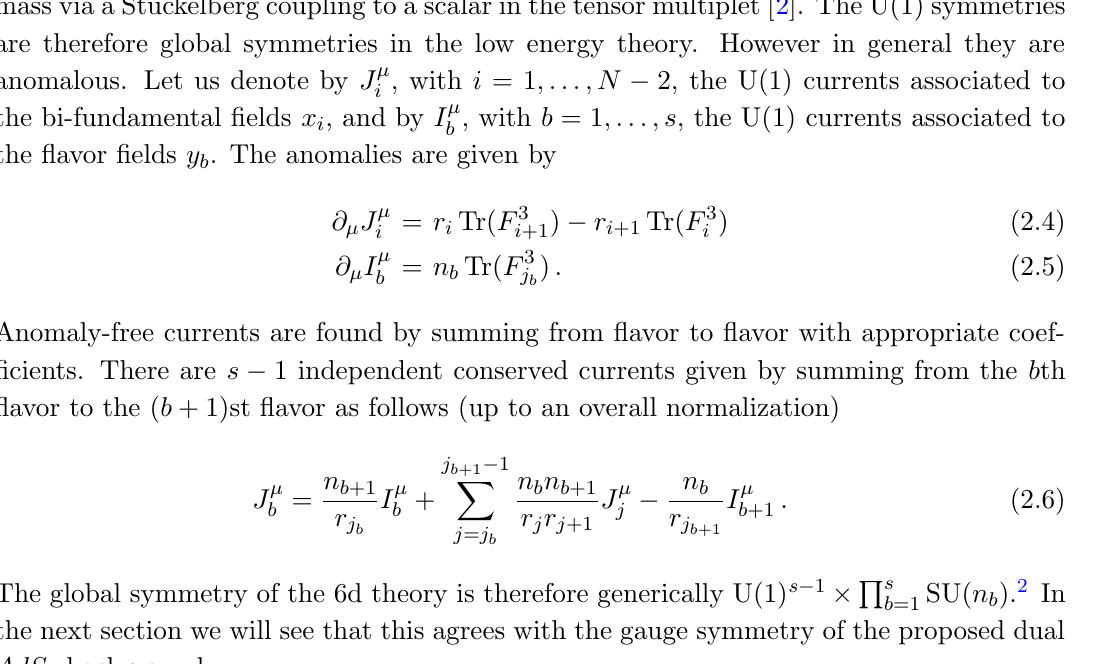
Figure 3 . The general 6d linear quiver theory with s sets of (cid:13)avors. We denote by x complex scalar components of the bi-fundamental hypermultiplets, and by y a ; ~ y a the two complex scalar components of the fundamental